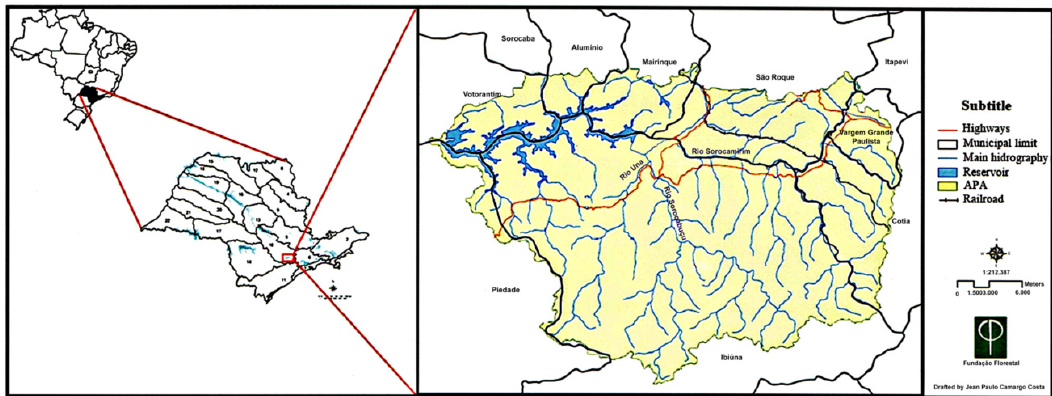
Figure 1. Localization of Itupararanga Reservoir in an environmental protection area, State of São Paulo,